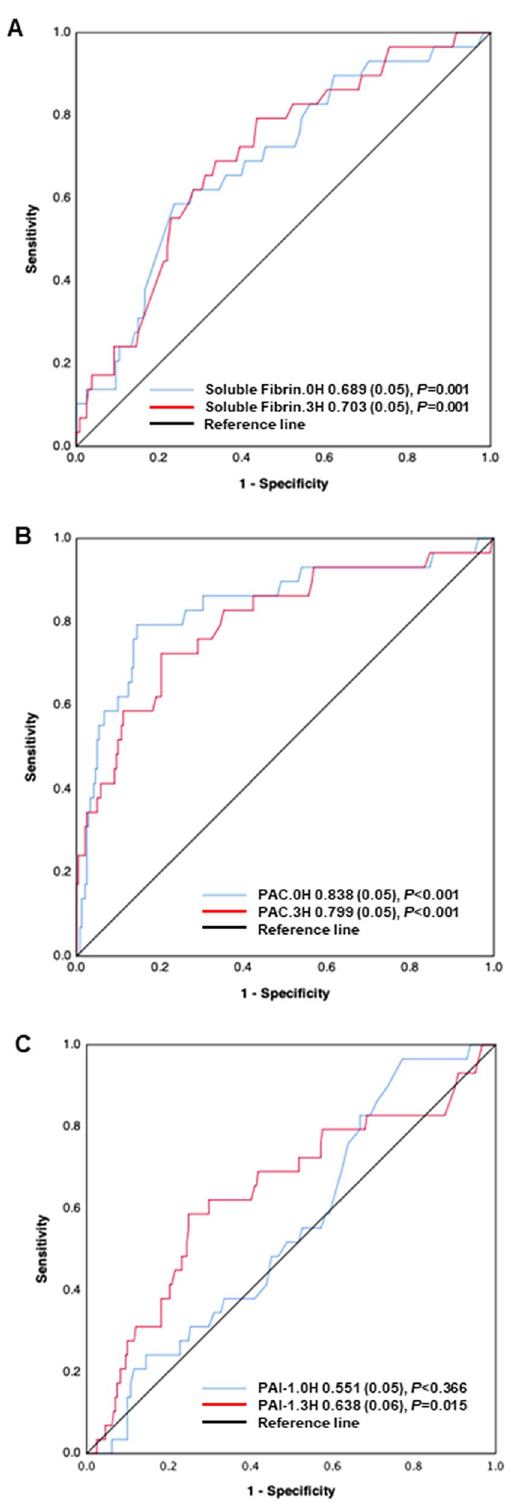
Figure 4. Receiver operating characteristics (ROC) curves of soluble fibrin, plasmin and antiplasmin complex (PAC) and plasminogen activator inhibitor-1 (PAI-1) at 0 and 3 h after presentation to the emergency department to predict hospital death. The number indicates the area under the ROC curve (AUC) (standard